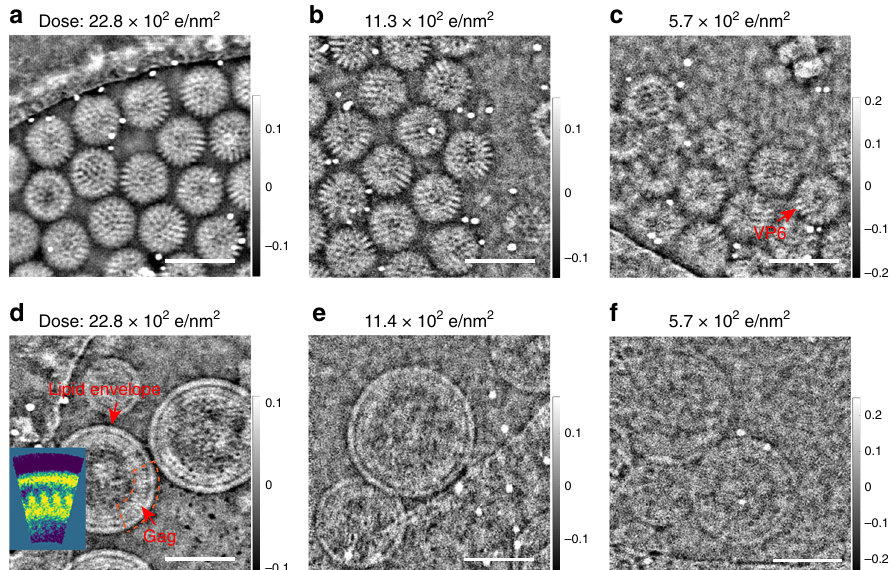
Fig. 3 Low-dose cryo-ptychographic reconstruction of viral particles. Reconstructed phase of rotavirus DLPs at doses of a 22.8 e/Å 2 , b 11.3 e/Å 2 and c 5.7 e/Å 2 . The red arrow in c indicates the VP6 trimers. Reconstructed phase of non-symmetrical immature HIV-1 VLPs at doses of d 22.8 e/Å 2 , e 11.4 e/Å 2 and f 5.7 e/Å 2 . The red arrows in d indicate the HIV-1 Gag protein and the lipid envelope. Inset to d is a rotational average of the sub-region indicated by the orange dashed line, (for details see Supplementary Fig. 10 and Supplementary Note 7). Scale bars: 100